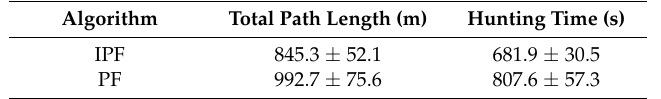
Table 1. Performance comparison between improved potential field (IPF) and potential field (PF).